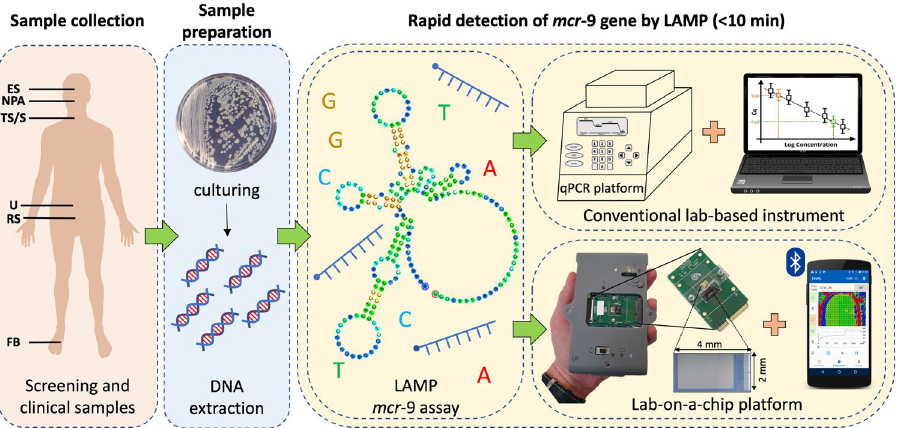
Figure 1. Diagnostic workflow for detection of mcr − 9 using LAMP. Clinical and screening samples are collected from: ES, eye swab; NPA, nasopharyngeal aspirate; TS, throat swab; S, sputum; U, urine; RS, rectal swab; and FB, foot biopsy. Subsequently, samples are cultured and nucleic acids are extracted in a